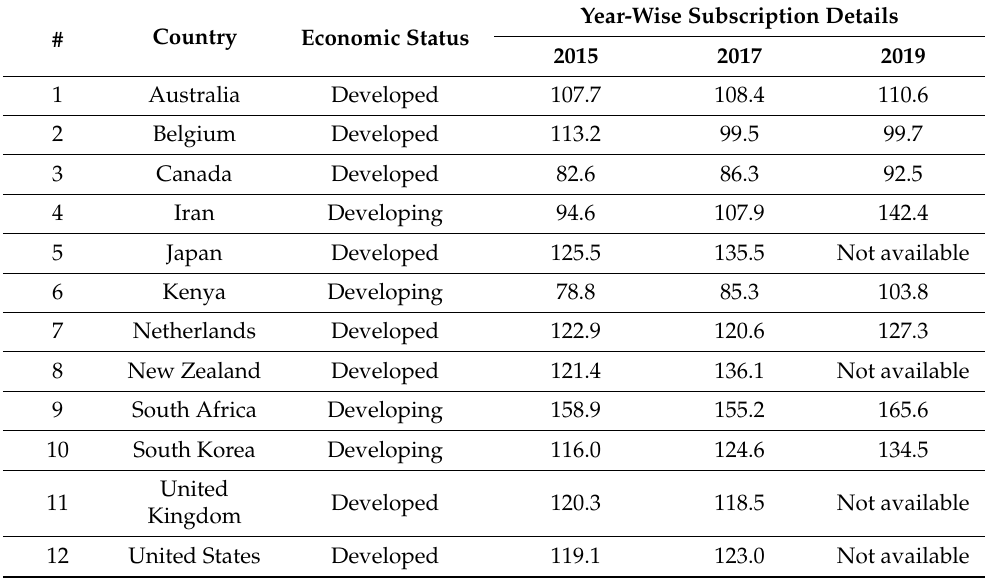
Table 3. Mobile cellular subscriptions (per 100 people) (adapted from